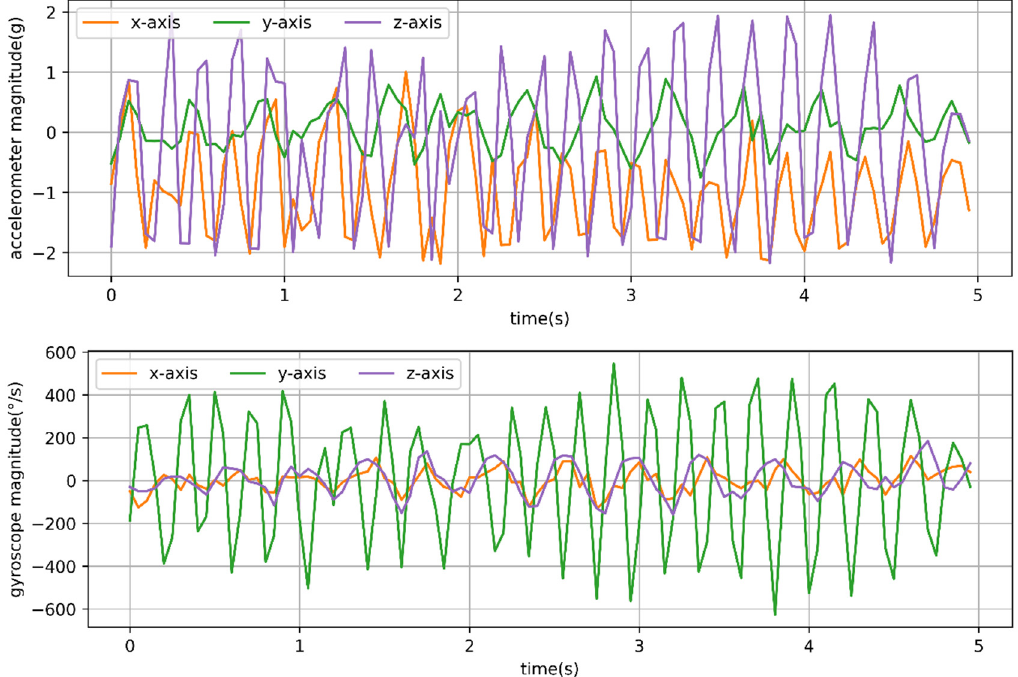
Figure 6. Time series of three-axis accelerometer and three-axis gyroscope signals from a 20 Hz sampling rate for observed behavior of 5 s of running. Acceleration was in g (9.8 m/s 2 ) units.